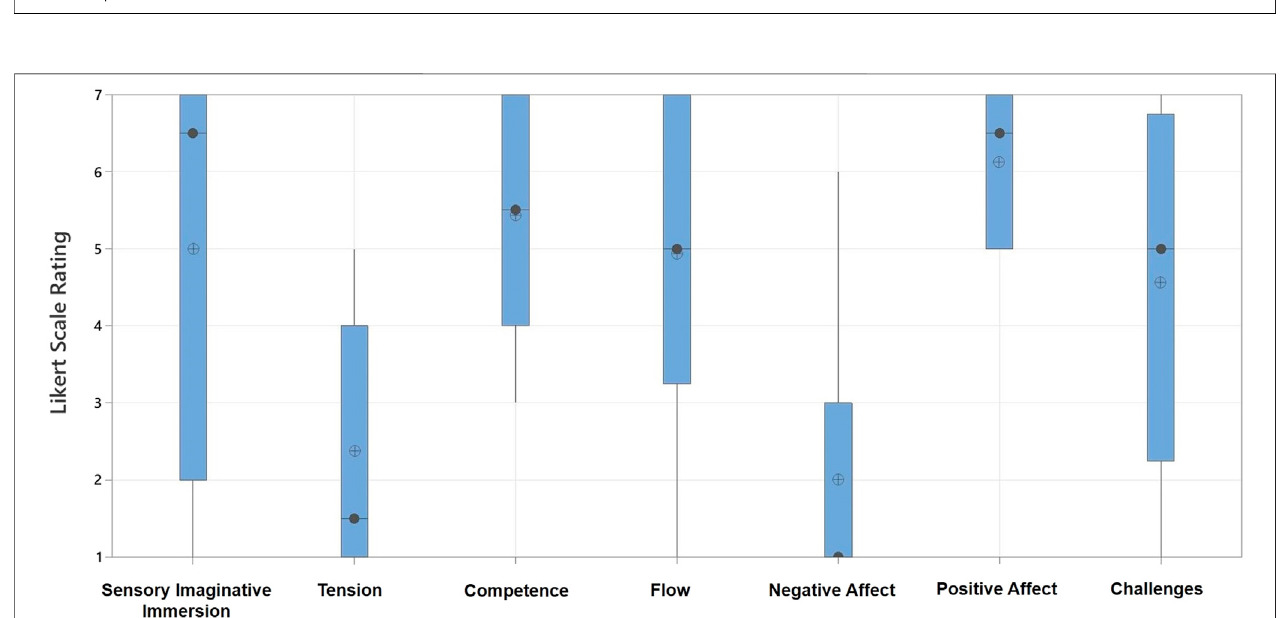
FIGURE 7 | participants ratings of each component of the GEQ questionnaire as part of the post-study questionnaire.